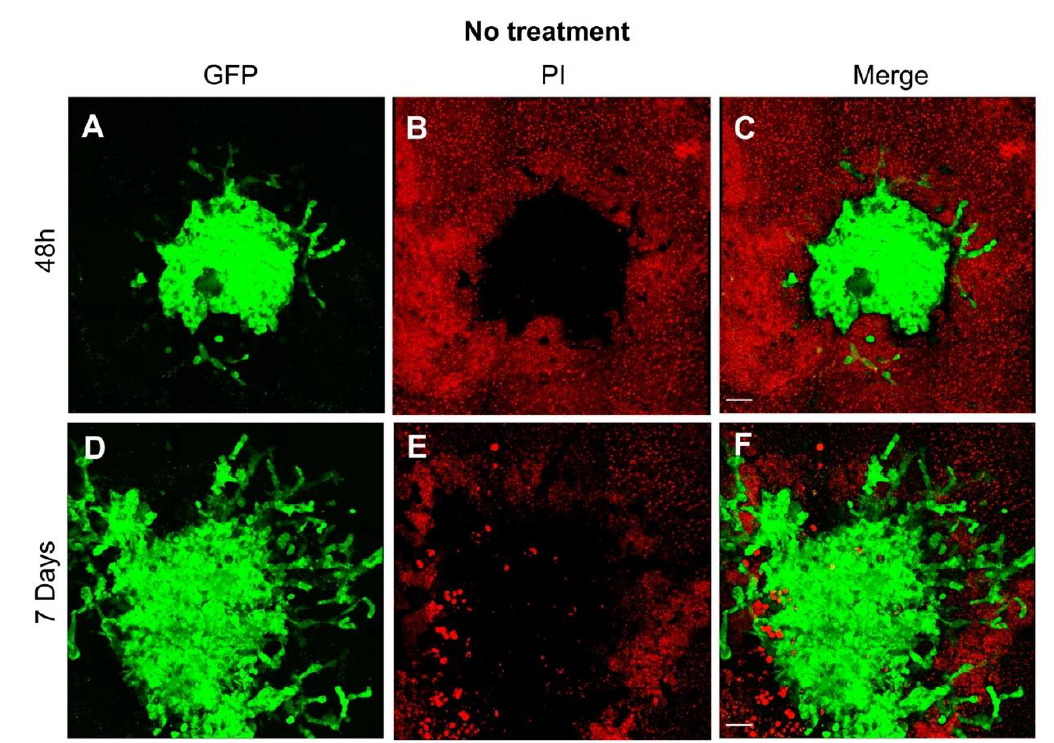
Figure 2. Visualization of the growth pattern of the glioblastoma cell line U87 co-cultured with organotypic brain slices. ( A ) As early as 48 h after transplantation, the tumor sphere demonstrated the first evidence of invasion as depicted by the green fluorescence of the human GB cell line U87GFP+; ( B ) the organotypic brain slices demonstrate a typical red fluorescence 2 h after propidium iodide staining; ( C ) the tumor growth on the surface of the organotypic brain slice is visualized on the merged figure; ( D ) One week after transplantation, the tumor demonstrated a considerable growth, and the GB typical invasion of the surrounding brain tissue; green fluorescence of U87GFP+; ( E ) red fluorescence 2 h after propidium iodide staining; ( F ) merged. Magnified by 20X. The scale bar represents 100 µm.